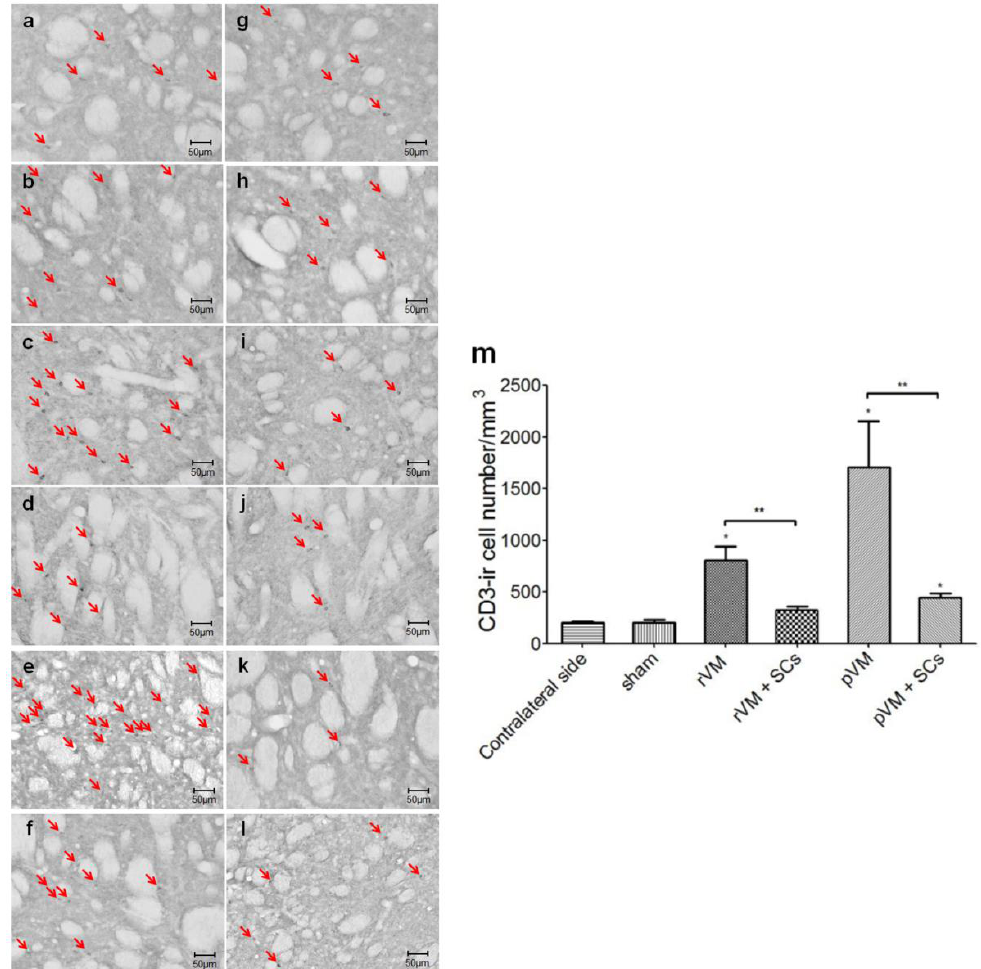
Figure 10. Grafted striatum and contralateral striatum stained with anti-CD3 antibody. Photomicrographs of grafted striatum: ( a ) Sham group, ( b ) SCs group, ( c ) rVM group, ( d ) rVM + SCs group, ( e ) pVM